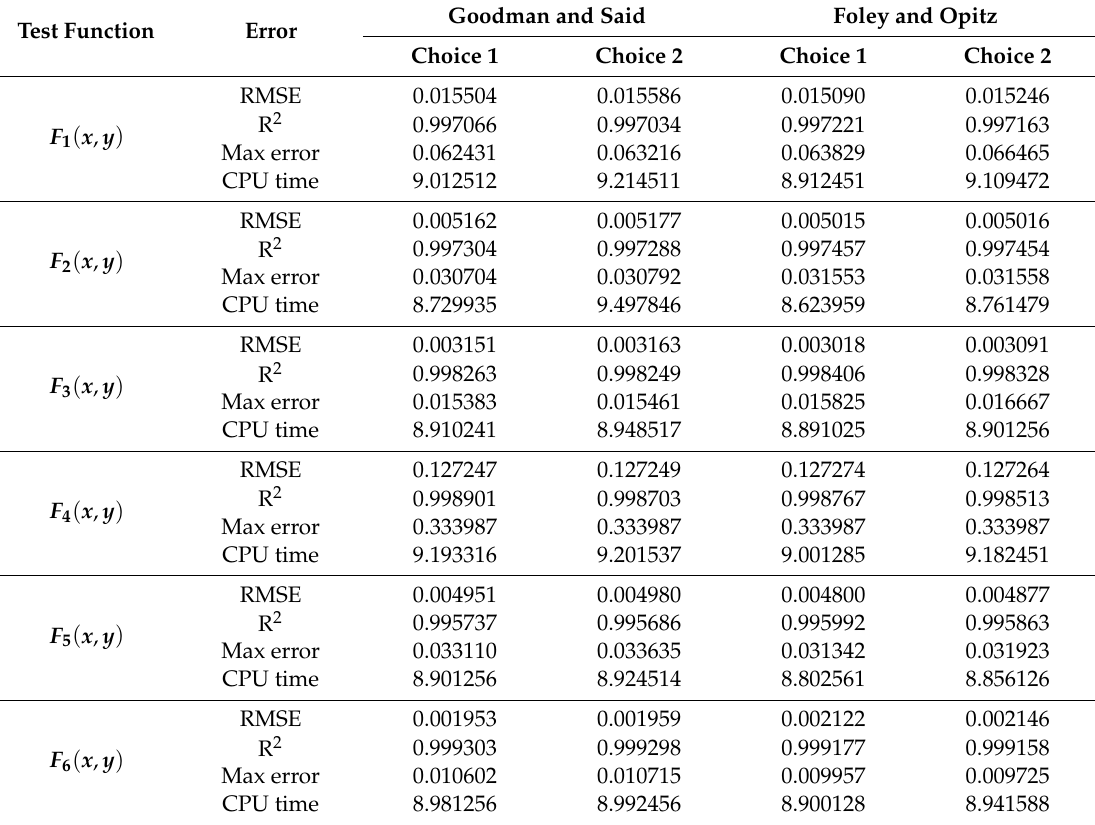
Table 6. Error analysis for 65